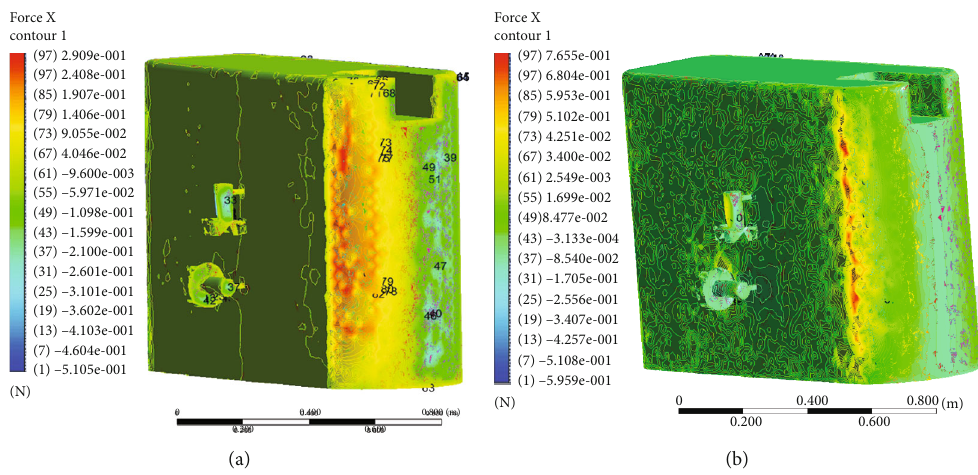
Figure 4: Viscous hydrodynamic contour: (a) force X contour; (b) force Y contour.